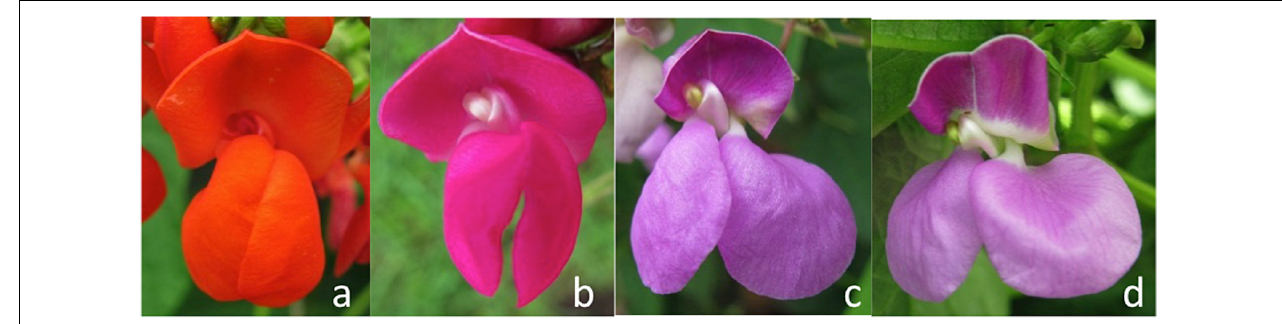
FIGURE 5 | Flowers of species of section Phaseoli DC often pollinated by hummingbirds: (a) P. coccineus , (b) P. costaricensis , (c) P. dumosus , and (d) P. vulgaris ; note that in (c) in contrast to (d) the flower has not been visited yet (photographs taken by D.G.